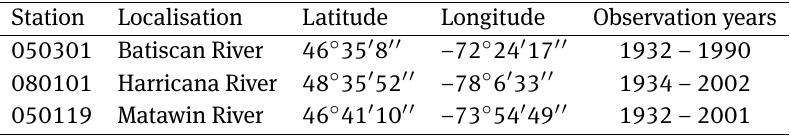
Table 1: Station